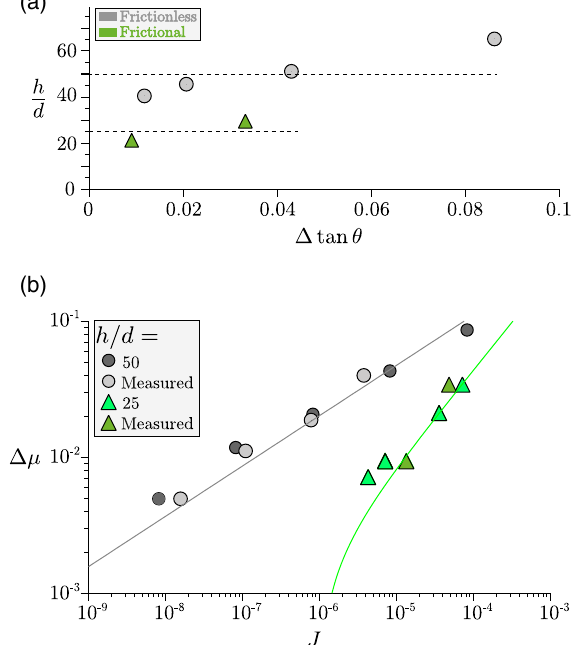
FIG. 6. (a) Flowing thickness h=d of the avalanche in the steady states measured at the front wall of the drum using particle image velocimetry, as a function of the reduced avalanche angle Δ tan θ for frictionless (grey circles, ½ NaCl (cid:3) ¼ 10 − 6 mol · L − 1 ) and frictional (green triangles, ½ NaCl (cid:3) ¼ 10 − 1 mol · L − 1 ) particles (silica spheres of diameter d ¼ 23 . 46 (cid:2) 1 . 06 μ m and density ρ ¼ 1850 kg · m − 3 ). Dashed lines correspond to average values p h=d ¼ 25 (frictional grains) and h=d ¼ 50 (frictionless grains). Note that the flowing depth for frictionless particles is always =d ¼ 400 ) for which the much smaller than the critical depth ( h c weight of the grains overcomes the interparticle repulsive force so that contacts become frictional [10]. (b) Rheology μ ð J Þ extracted from the stationary regimes using the averaged value of h=d or the measured values shown in Fig. 3(a) for computing the viscous number J ¼ ηω R 2 = ð h 2 P Þ [grey symbols are frictionless grains and green symbols are frictional grains; we use the same experimental conditions as in Fig.